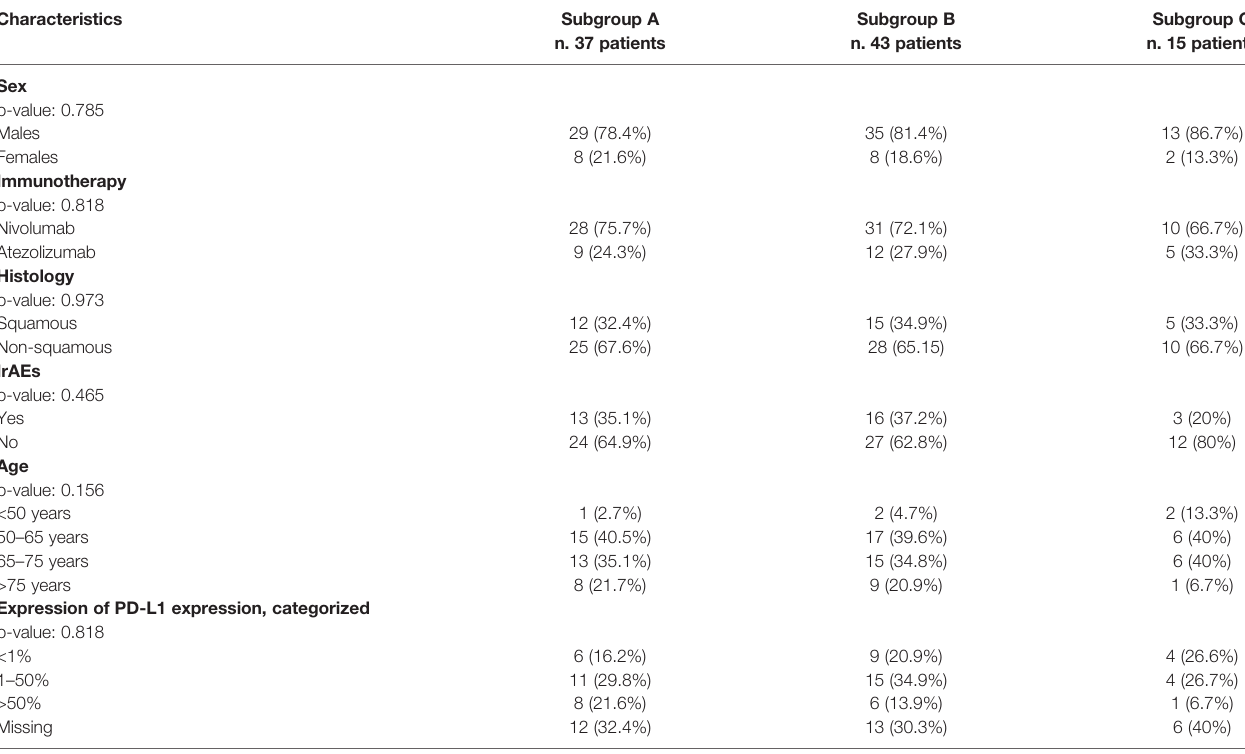
TABLE 2 | Clinical characteristics of the three cohort of